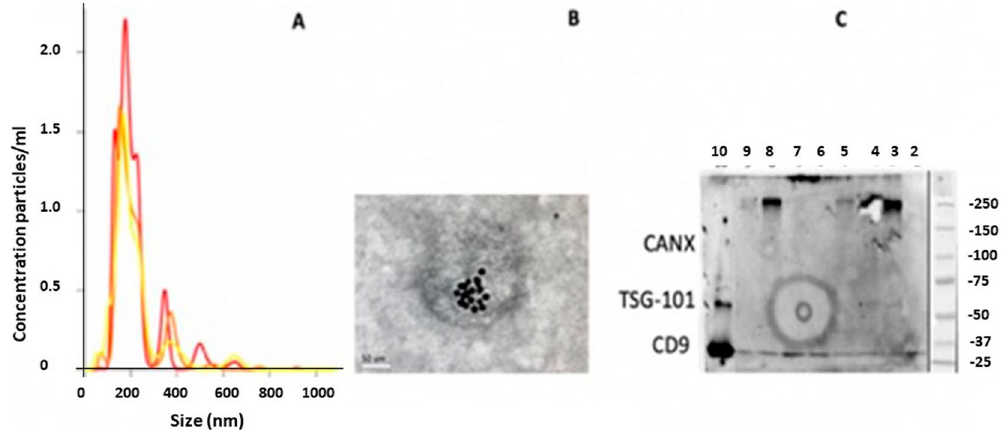
Figure 1. Validation and characterization of isolated EV: Size and concentration distribution of nanoparticles from NTA in triplicate (yellow, red and orange graphs) ( A ); ds-DNA antibody labelled TEM image at magnification × 40,000 ( B ); and Western blots using common exosome markers (positive for CD9 and negative marker Calnexin) in melanoma cell lysate (SKMel28) as positive control (lane 10) and isolated EV (lane 7) ( C ). Lanes 2, 3, 4, 5, 6, 8, 9 were of other samples that were included in the same Western Blot analysis, but were not patients included in the study.